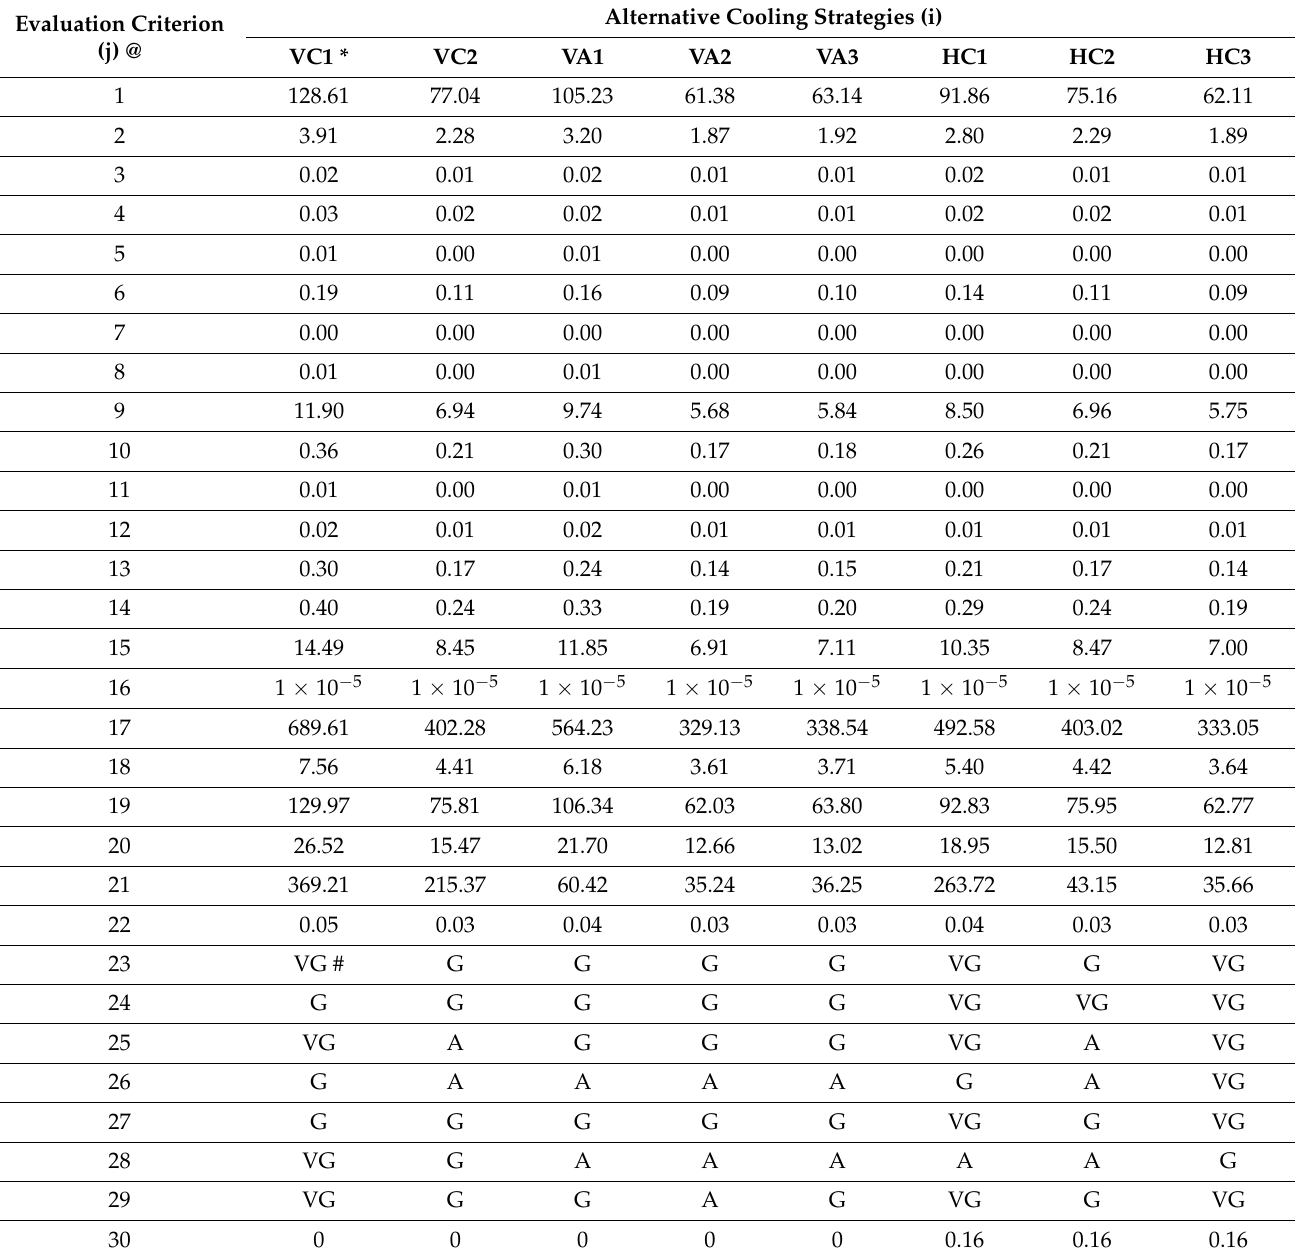
Table 4. The data of evaluation criterions corresponding to cooling strategies for dry arid climate. Evaluation Criterion